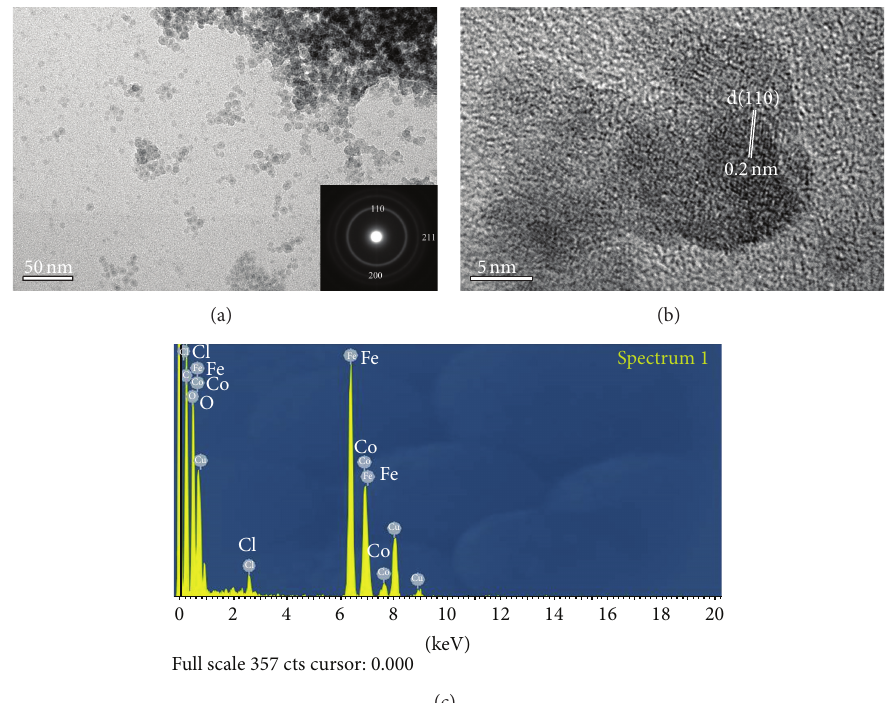
Figure 2: (a) TEM micrograph of W3 sample (inset: selected area diffraction pattern). (b) High resolution TEM image of W3 sample. (c) EDS spectra of W3 sample showing Fe, Co, Cl, and O